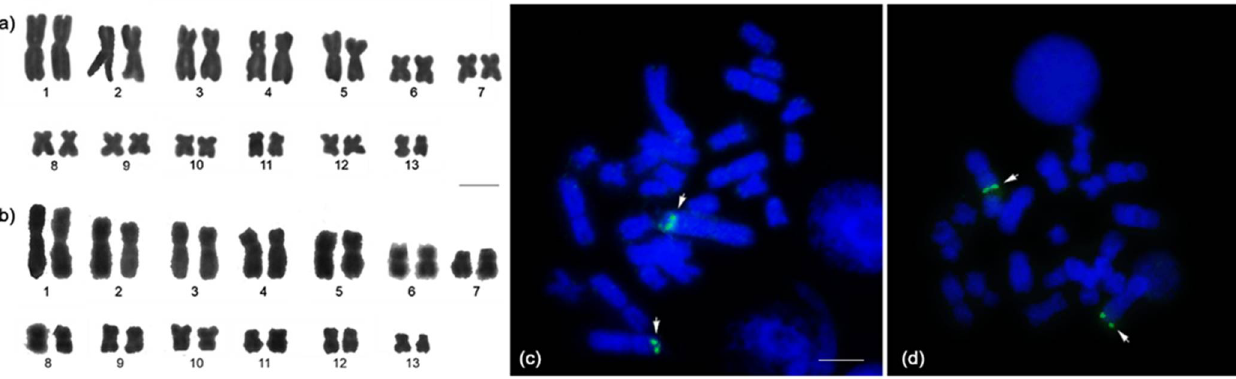
Figure 2. Karyotype and chromosomal locations of microsatellite repeat motifs of the rice field frog ( Hoplobatrachus rugulosus Wiegmann, 1834). Giemsa-stained karyotype of the rice field frog ( H. rugulosus ) ( a ) males and ( b ) females. Hybridization patterns of FITC-labeled (AGAT) 8 on DAPI-stained chromosomes in ( c ) males and ( d ) females. Arrows indicate the hybridization signals. The scale bar represents 10 µm.